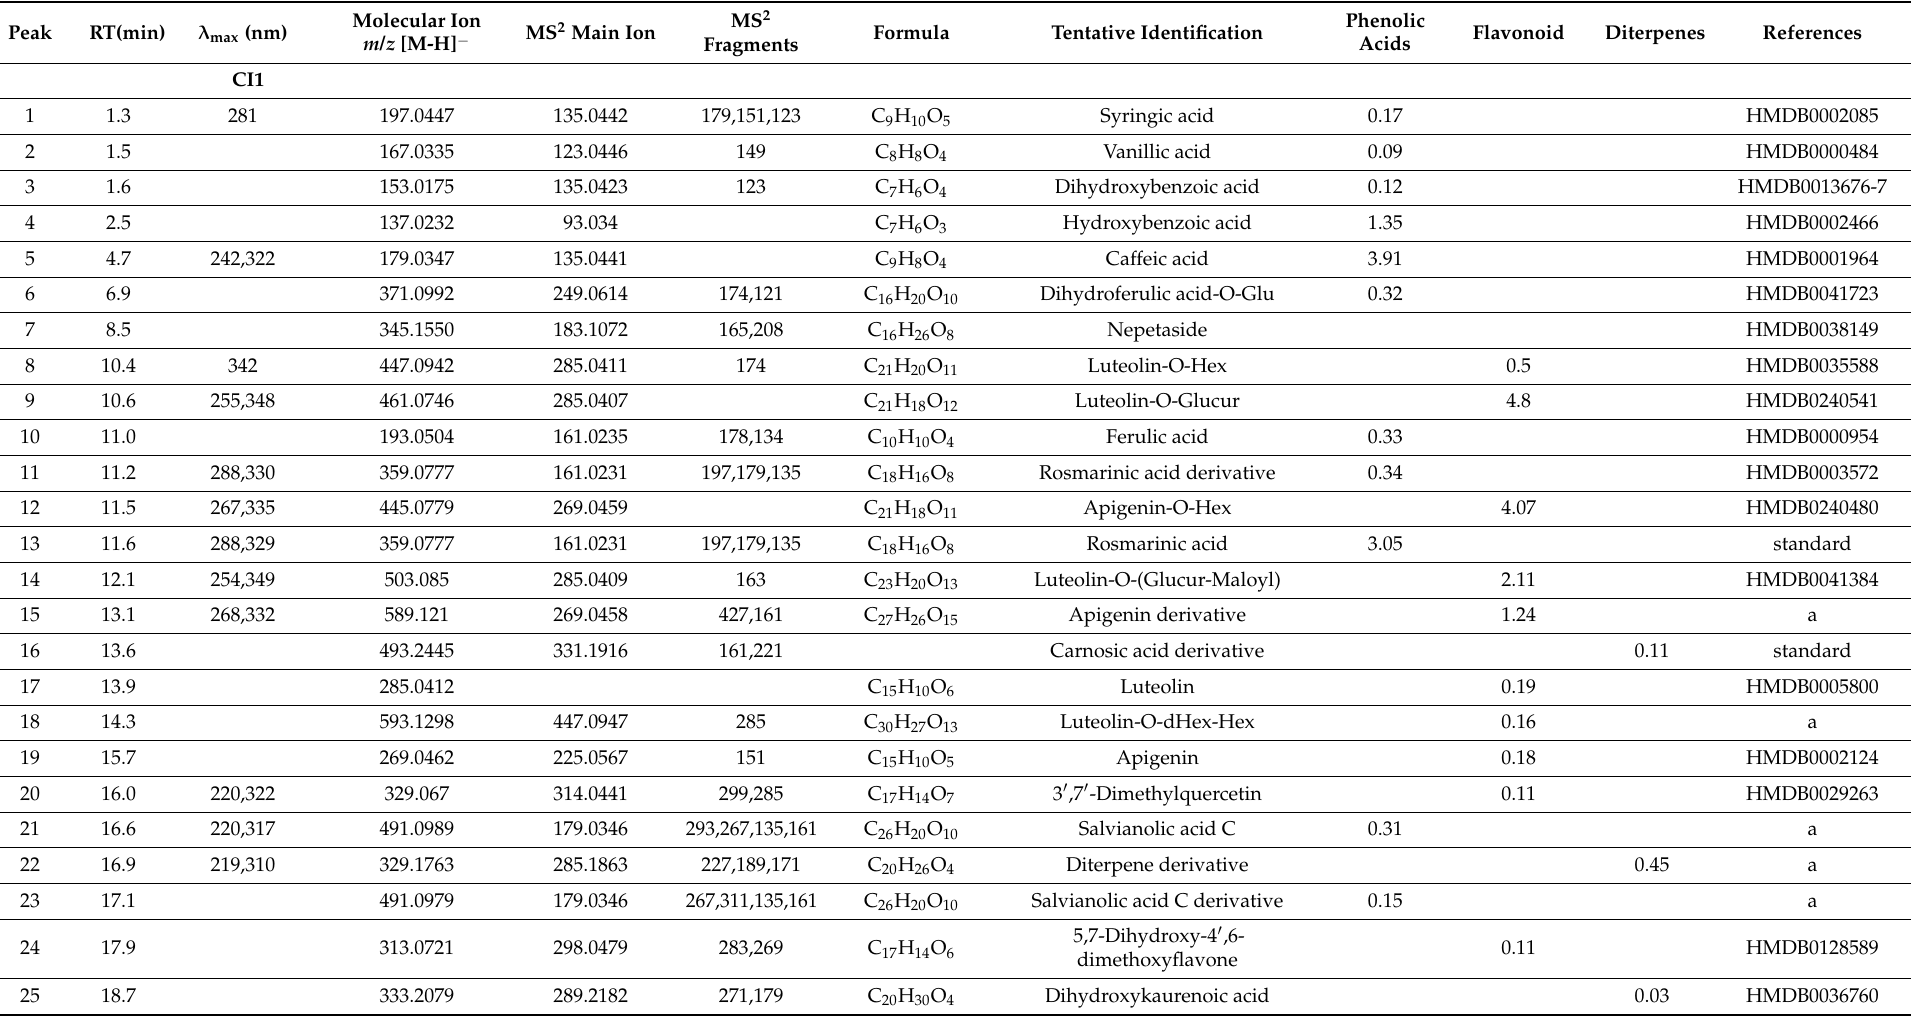
Table 1. The most abundant, tentatively identified compounds in the Coleus amboinicus samples from Indonesia (CI1, CI2) and Poland (CPL, CPF, CPS, CPT); their contents were estimated using carnosic acid (for diterpenoids), rosmarinic acid (for phenol carboxylic acids) and isoquercitrin (for flavonoids) evaluation (mg · g − 1 extract, n = 3, mean